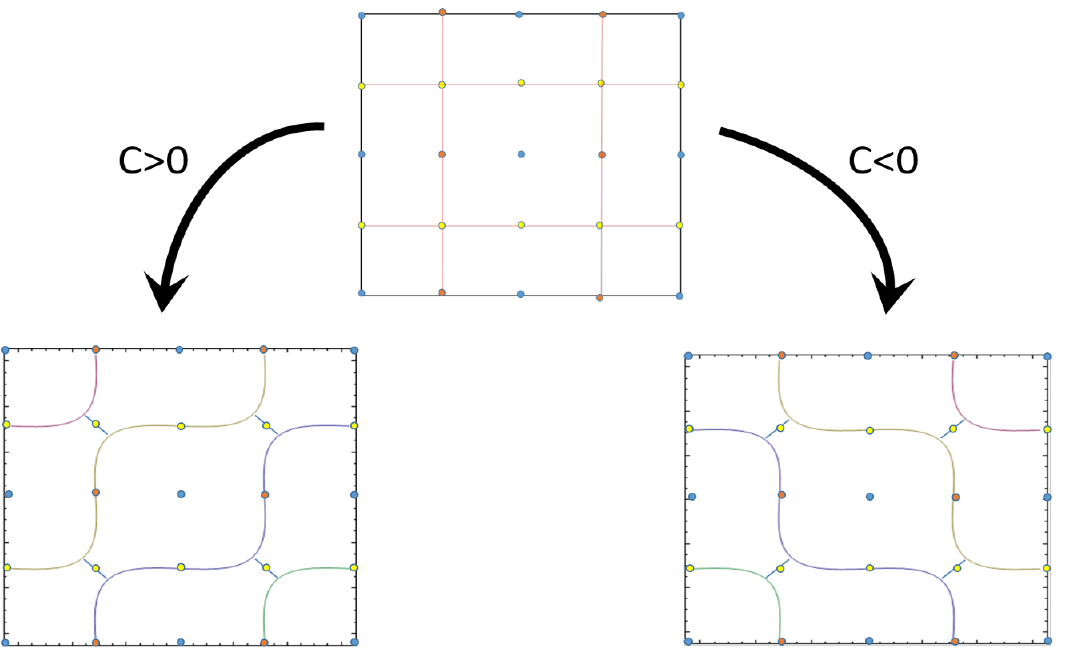
The upper (cid:12)gure represnts the phase diagram of two decoupled SU( N ) theories.